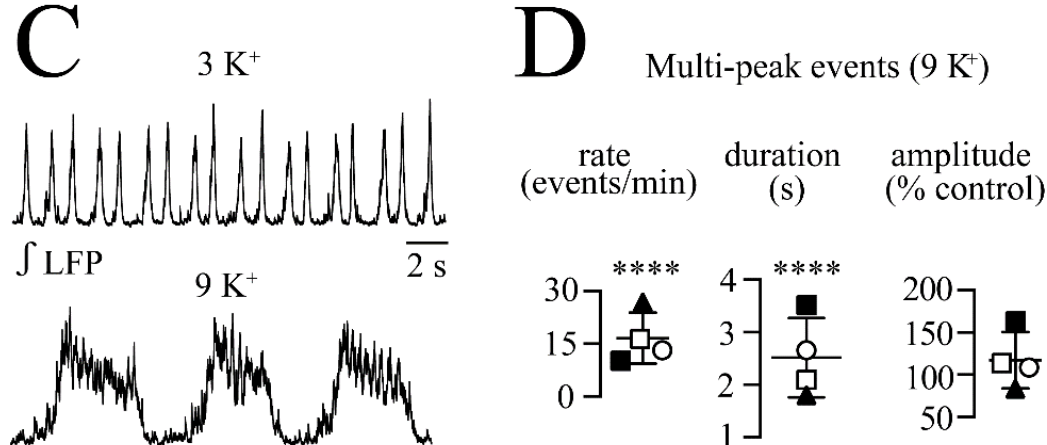
Figure 8. Effects of raised extracellular K + on LFP . ( A ) The recordings from a single slice show that raising superfusate K + from physiological 3 mM to 5, 7, or 9 mM shows a trend for accelerating the of the LFP and shortening its duration. ( B ) shows that only 9 mM had a significant effect though, particularly on increasing LFP rate modestly from 60.0 ± 20.7 events/min to 91.4 ± 10.9 events/min,